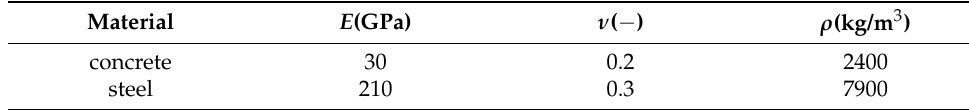
Table 1. Material parameters of steel and concrete used in the